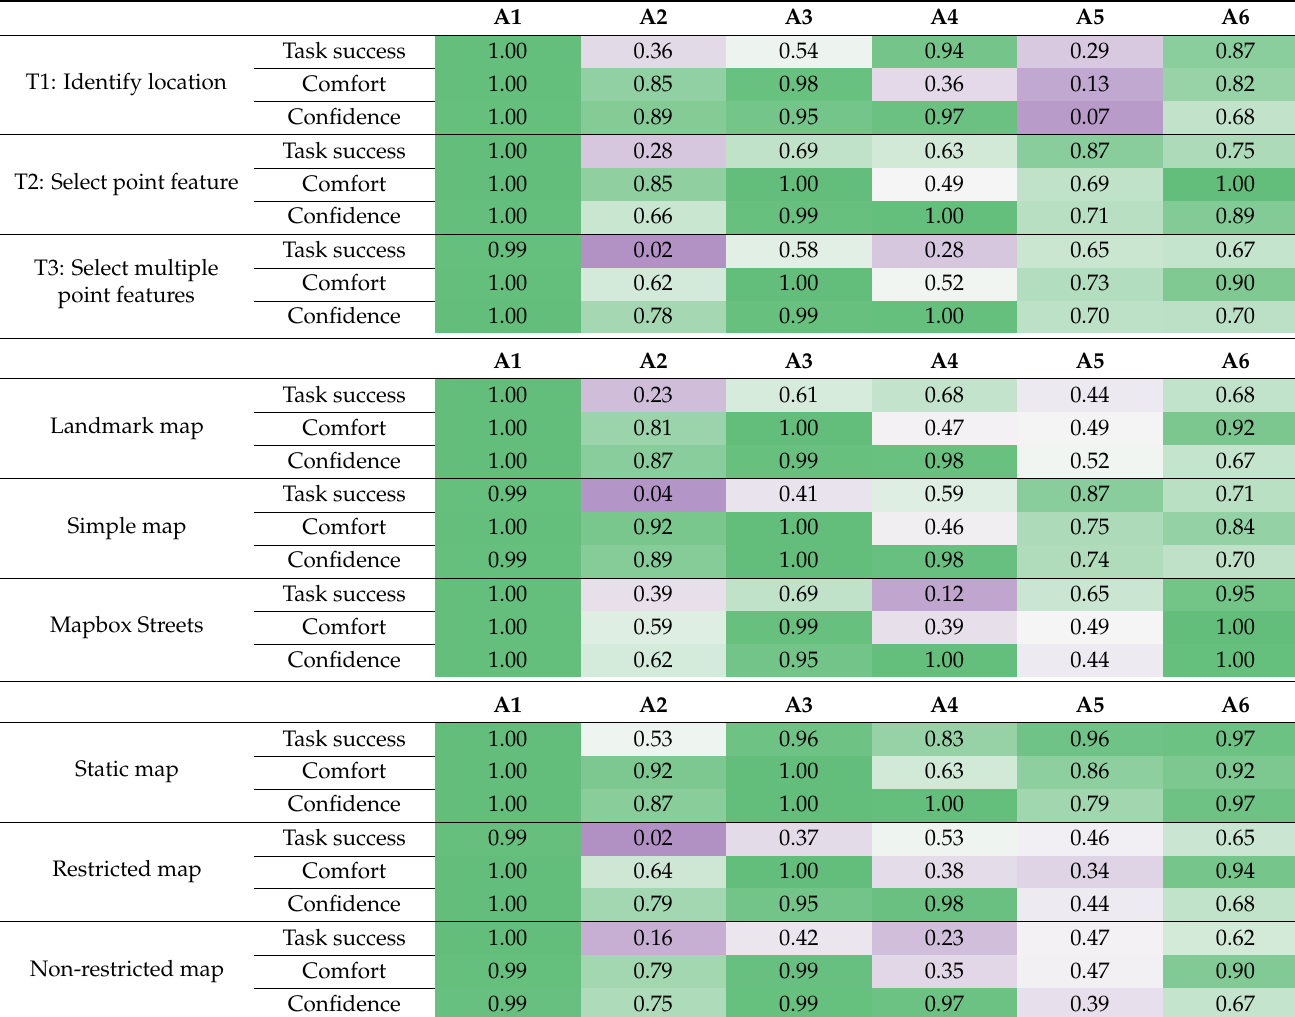
Table 4. Usability scores of map design variation categories by archetype (with purple colors indicating low values and green colors indicating high values on a standardized scale between 0 and